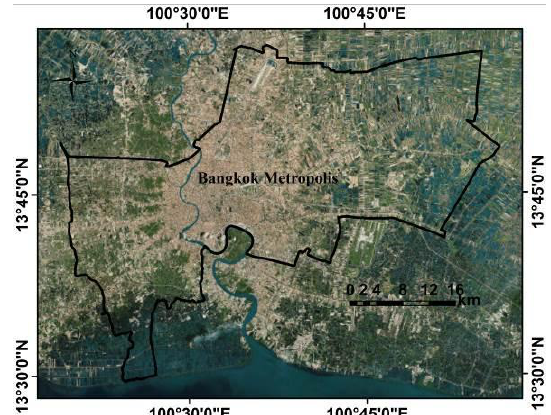
Figure 2. Bangkok metropolis area (boundary highlighted